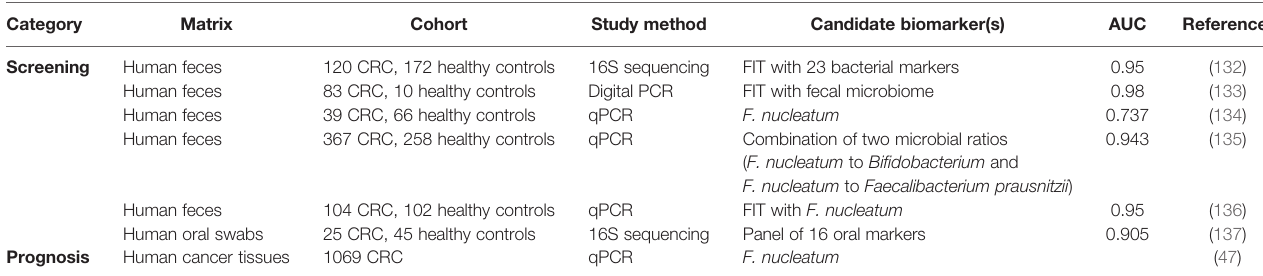
TABLE 2 | Intestinal microbiota biomarkers for colorectal cancer screening and prognosis.